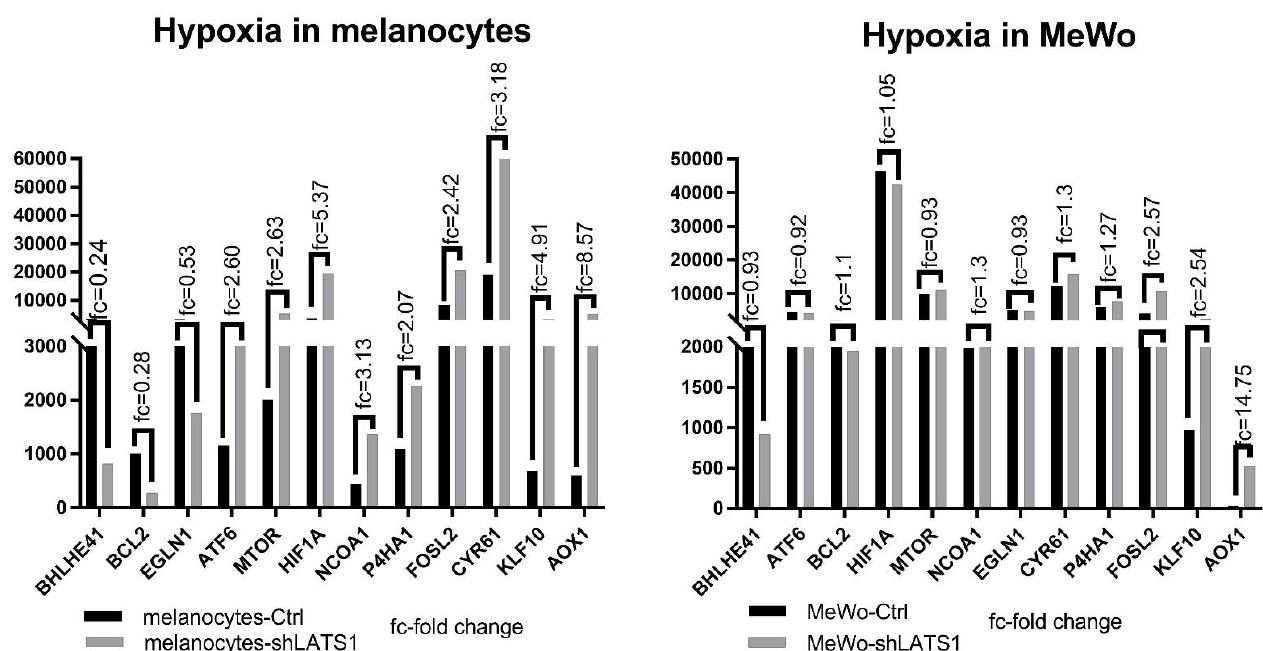
Figure 5. Expression of hypoxia-related genes in LATS1 knocked down cells. Comparison of the expression of the genes regulated under hypoxia in primary melanocytes (left) and MeWo cells (right), with fold changes of normalized expression values; black bars represent cells with regular LATS1 expression, grey bars represent cells with LATS1 knocked down.